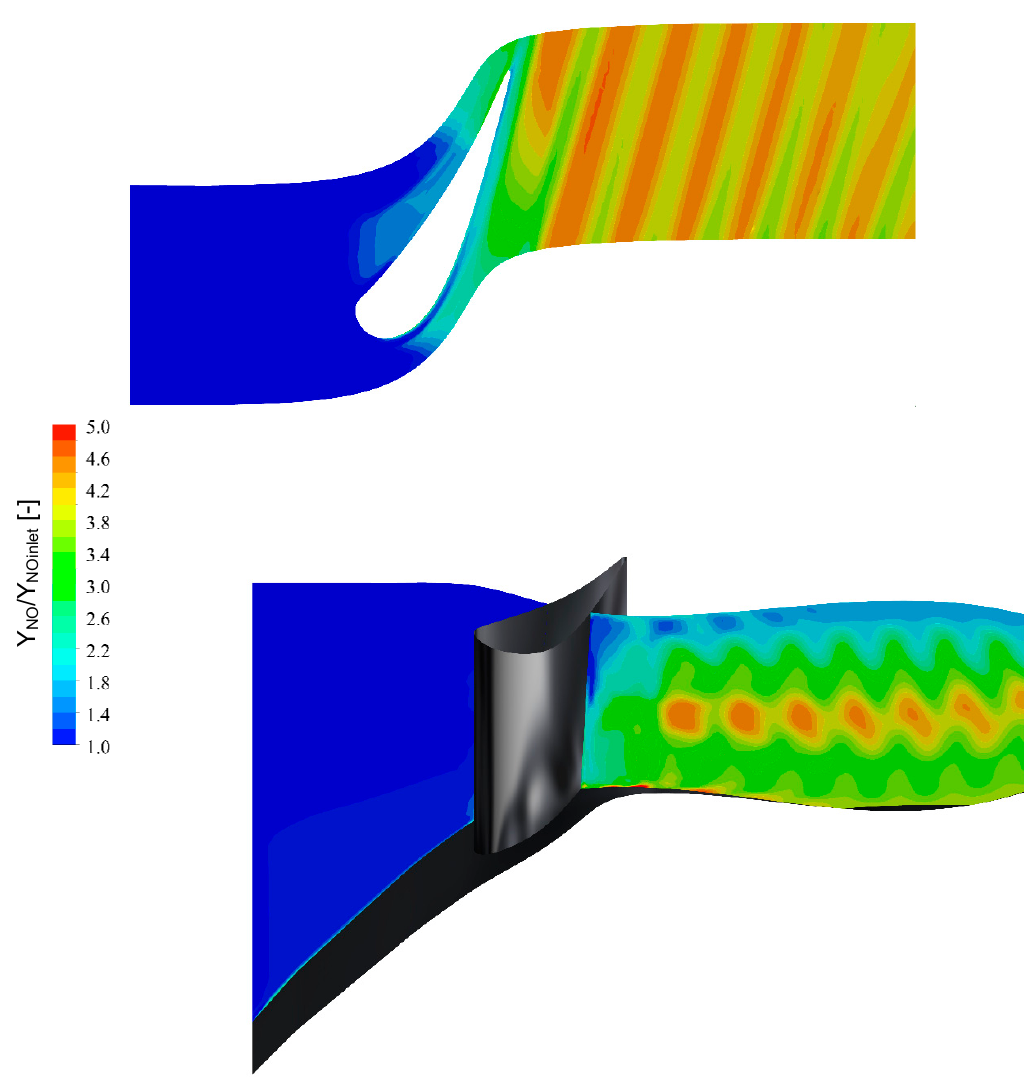
Figure 12. NO mass fraction contours non-dimensionalised by the inlet values for condition C with the FRC approach and the San Diego mechanism. A top view plane (above) and an axial plane (below).